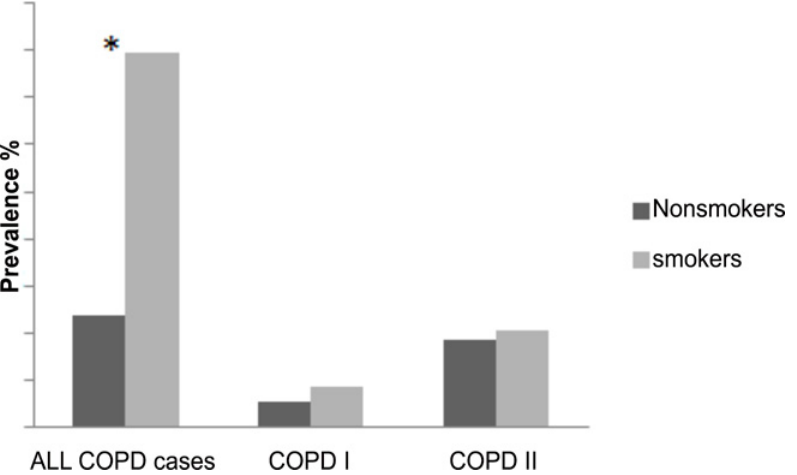
Stage I COPD; * : p < 0.01, Significant difference between smokers and nonsmokers.